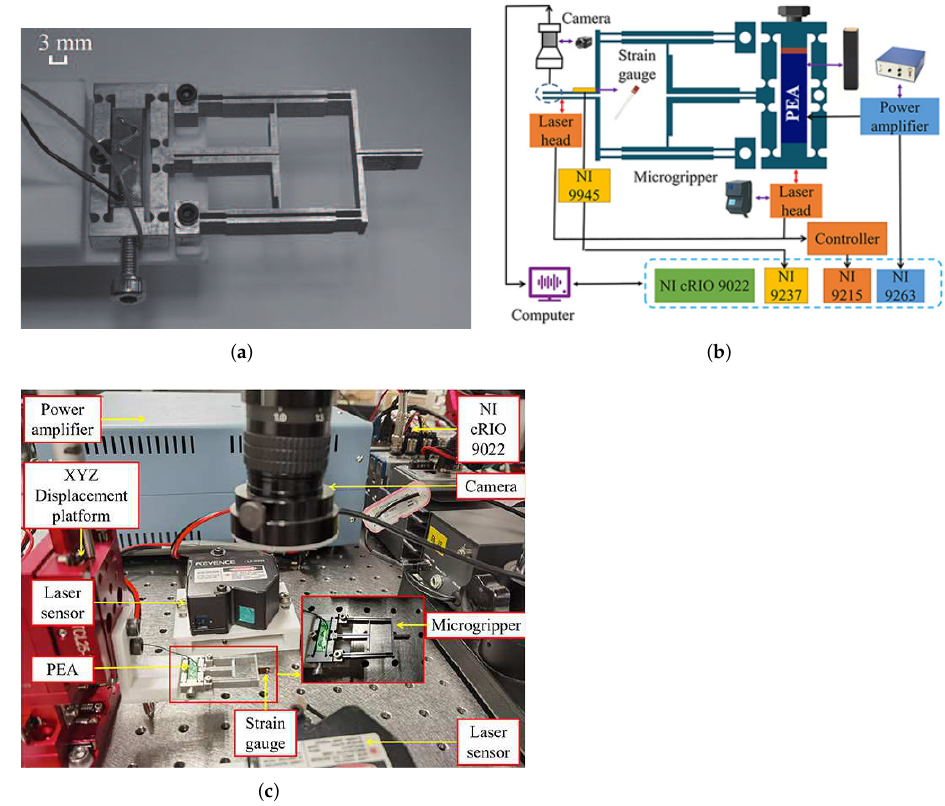
Figure 9. Experimental setup for the microgripper. ( a ) Fabricated prototype, ( b ) schematic diagram of the experimental setup, and ( c ) photo of the experimental